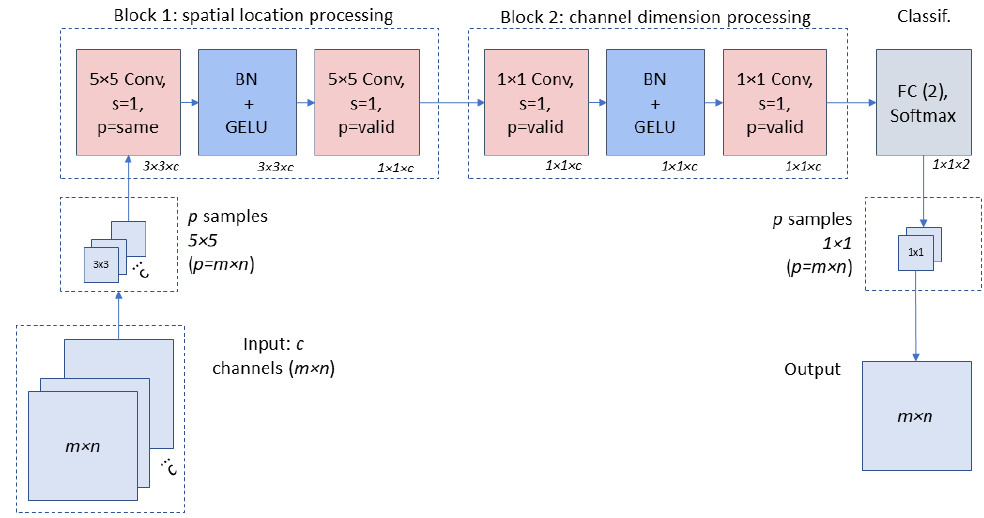
Figure 1. Proposed model for landslide susceptibility identification by means of remote sensing images and deep